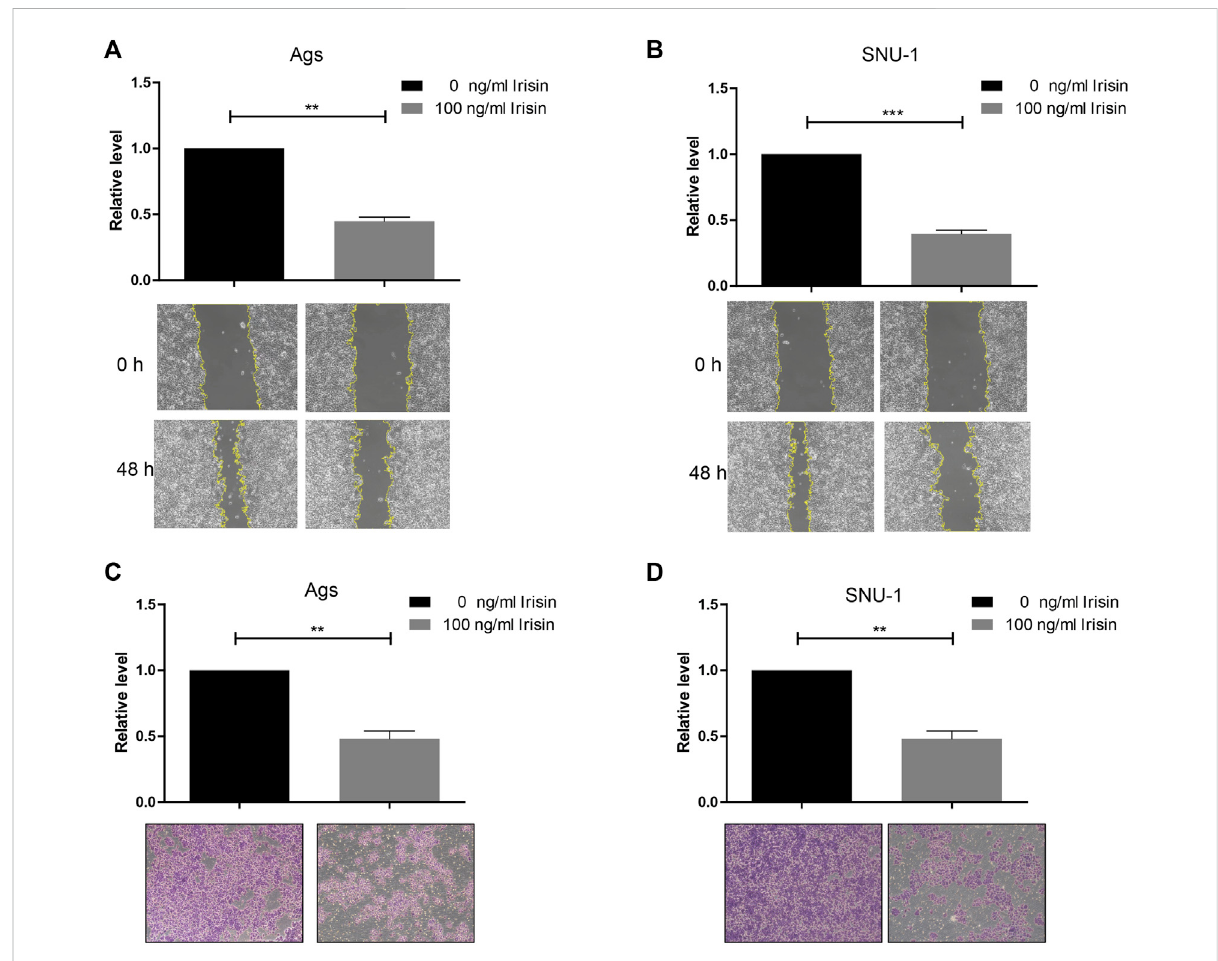
muscle contraction, regulation of system process, circulatory system process, heart process, regulation of heart contraction, regulation of blood circulation, smooth muscle contraction, regulation of muscle contraction (Figure 7F;